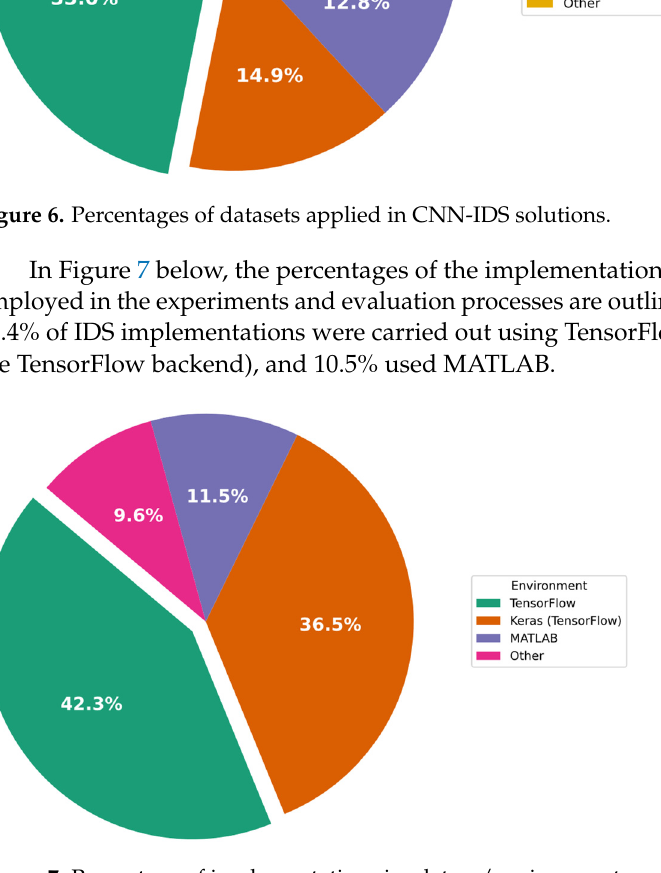
Figure 7. Percentage of implementation simulators/environments employed in the experiments.